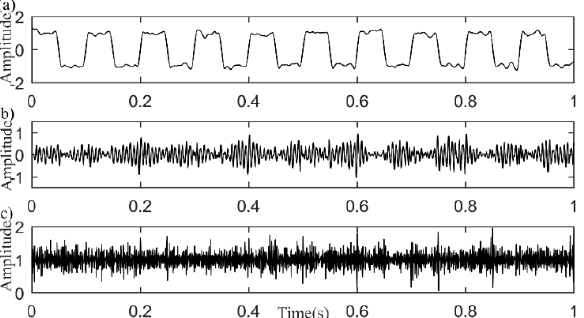
( ) x t Figure 3. Decomposition results of VMD for x 1 ( t ) . ( a ) Square wave components corresponding to Figure 3. Decomposition results of VMD for 1 . ( a ) Square wave components corresponding to IMF; ( b ) IMF corresponding to the AM–FM sine component; ( c ) Noise IMF; ( b ) IMF corresponding to the AM – FM sine component; ( c ) Noise component.